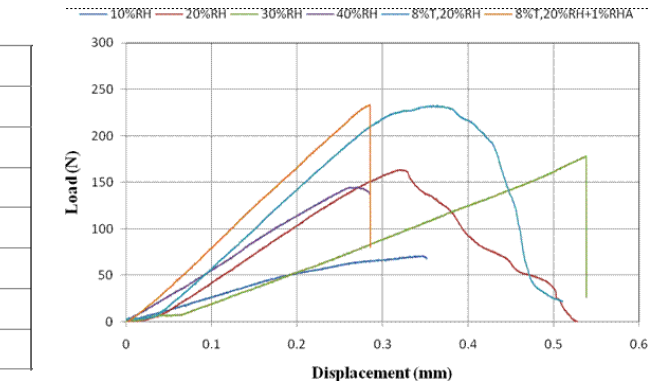
Figure 4: Comparison of fracture toughness of pure epoxy, un- treated 20 wt% reinforced and 8% alkali treated (20 wt%) rein- forced composite